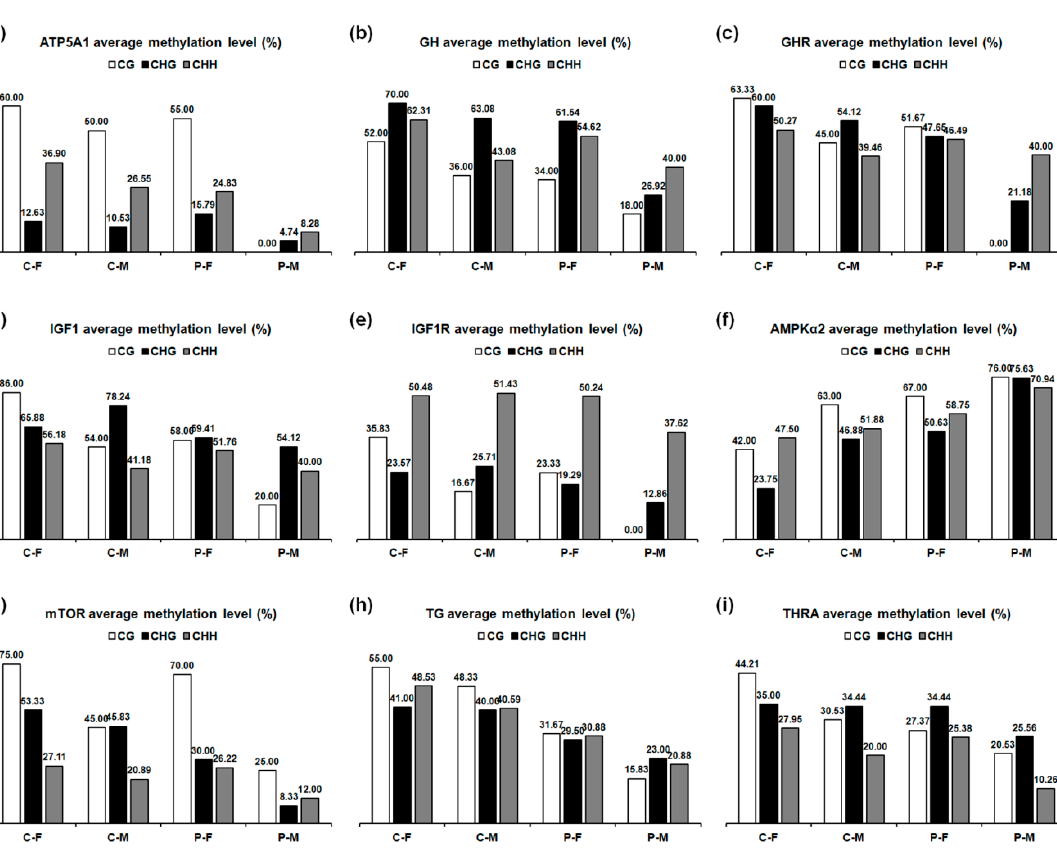
Table 2. DNA methylation levels (%).